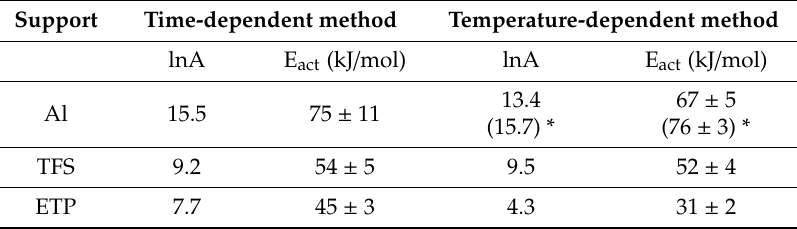
Figure 5. Second order kinetic fittings of esterification degree (p) for polyaleuritate coatings on Al, TFS and ETP substrates (symbol labelling is as in Figure 4). (Bottom-right) Arrhenius plots to calculate the activation energy (E act ) of the process. Table 2. Pre-exponential factor (A) and E act values for the esterification of polyaleuritate coatings on metal substrates using the time- and temperature-dependent methods.